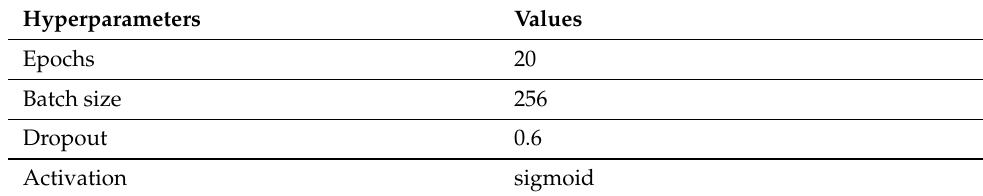
Table 2. Simulation